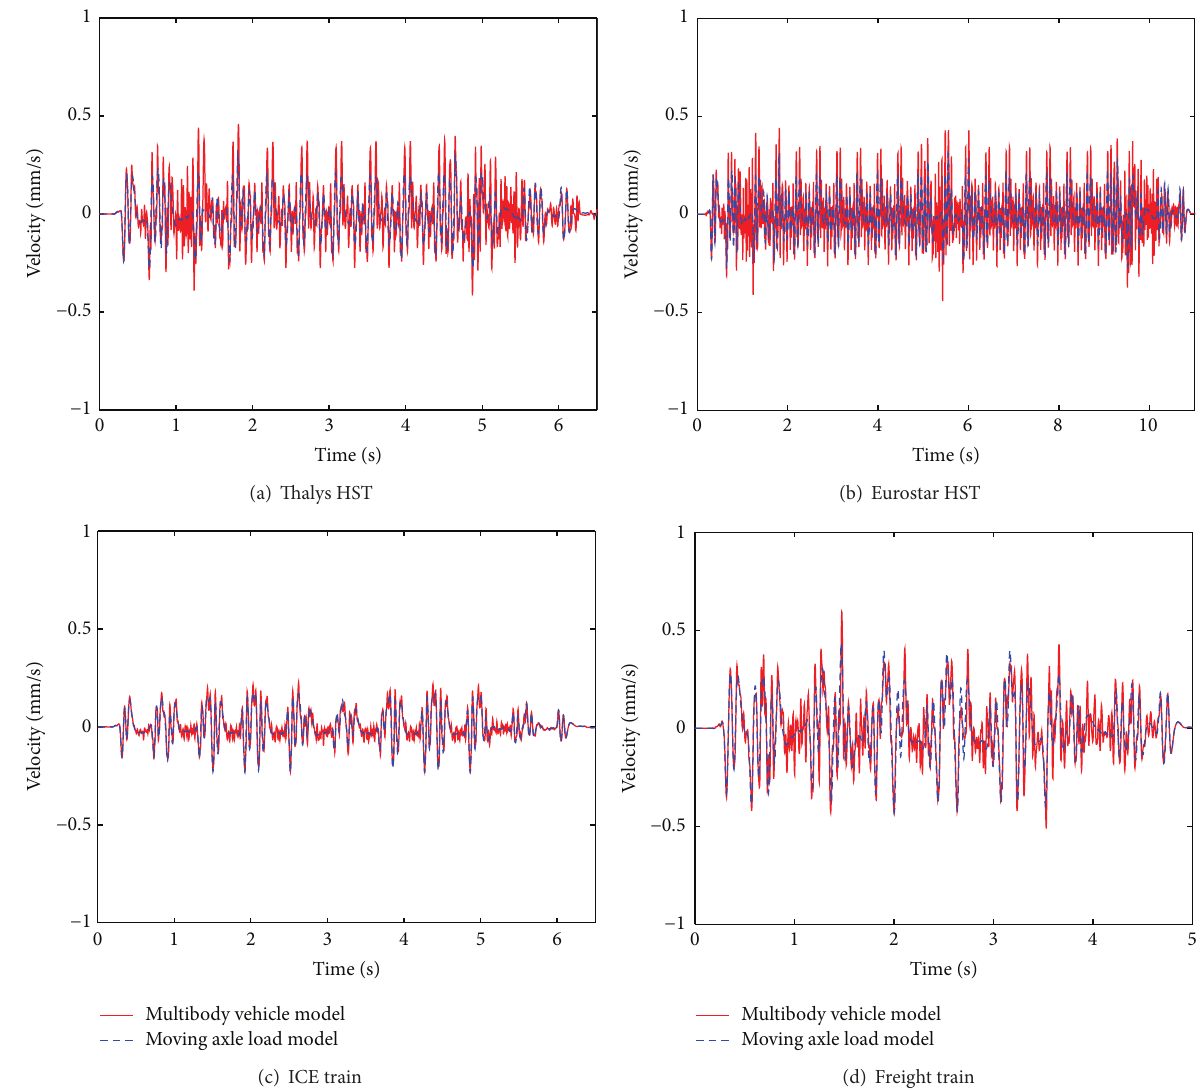
Figure 9: Time histories of vertical ground surface velocity induced by the studied trains, at 10 m from the track, for a vehicle speed of 150